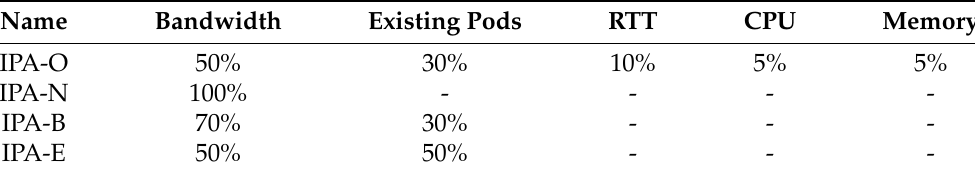
Table 1. Different weight configurations of the IPA